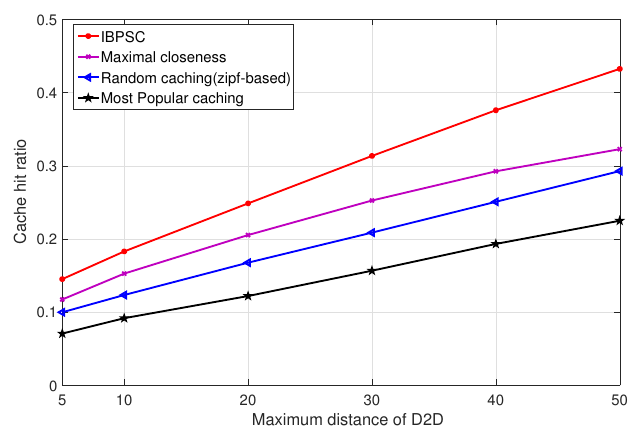
Figure 9. Cache hit ratio vs. maximum D2D communication